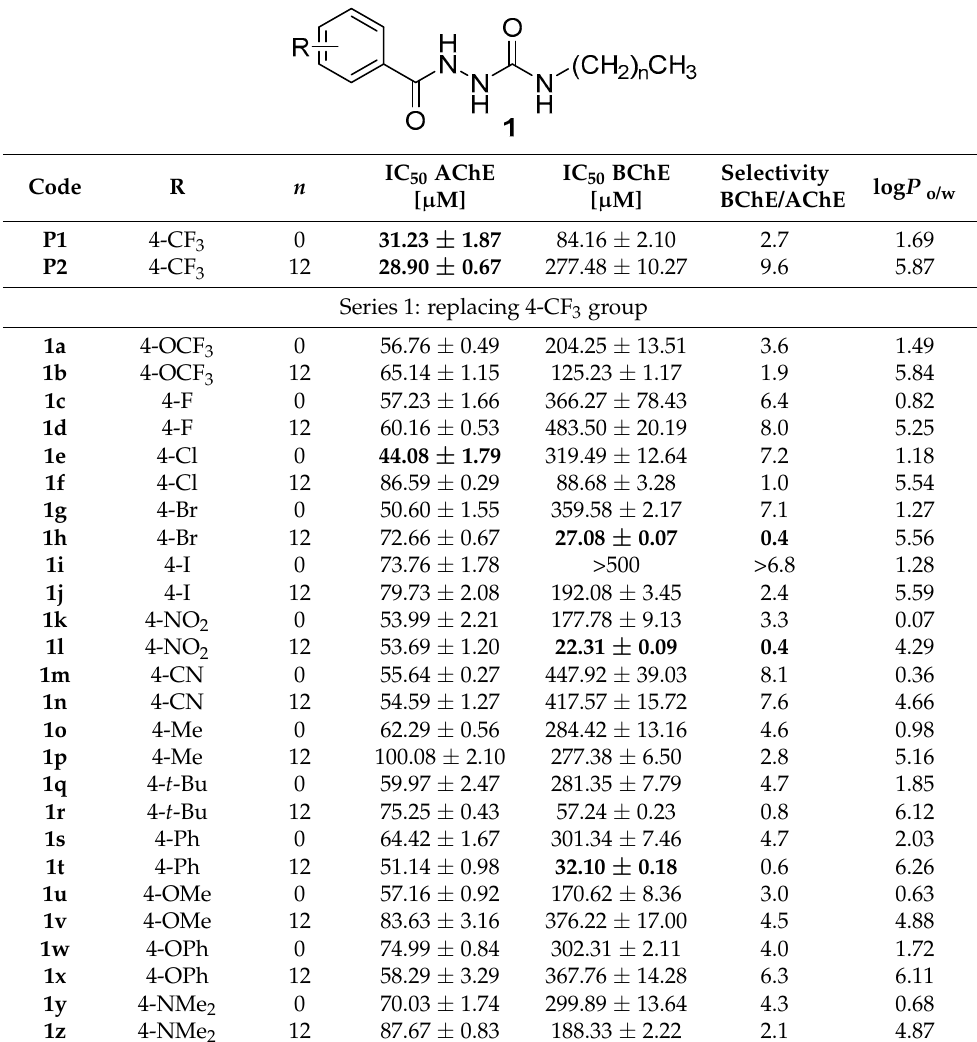
Table 2. Inhibition of AChE and BChE, selectivity indexes and lipophilicity of hydrazinecarbox- amides 1–3 .